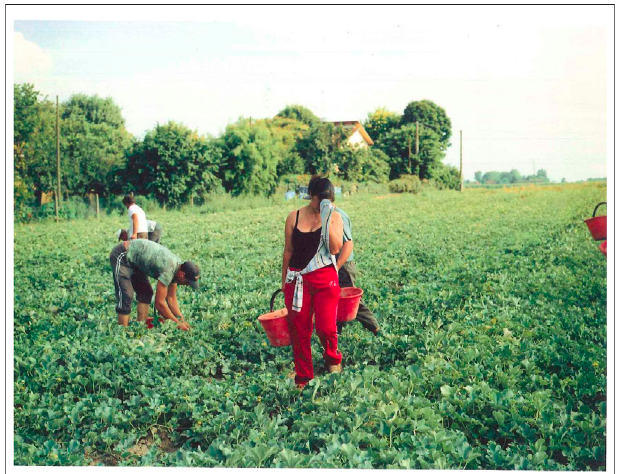
FIGURE 3 | From the series Land ohne Eltern (land without parents). Photo Andrea Diefenbach (2012). FIGURE 1 | From the series Land ohne Eltern (land without parents).